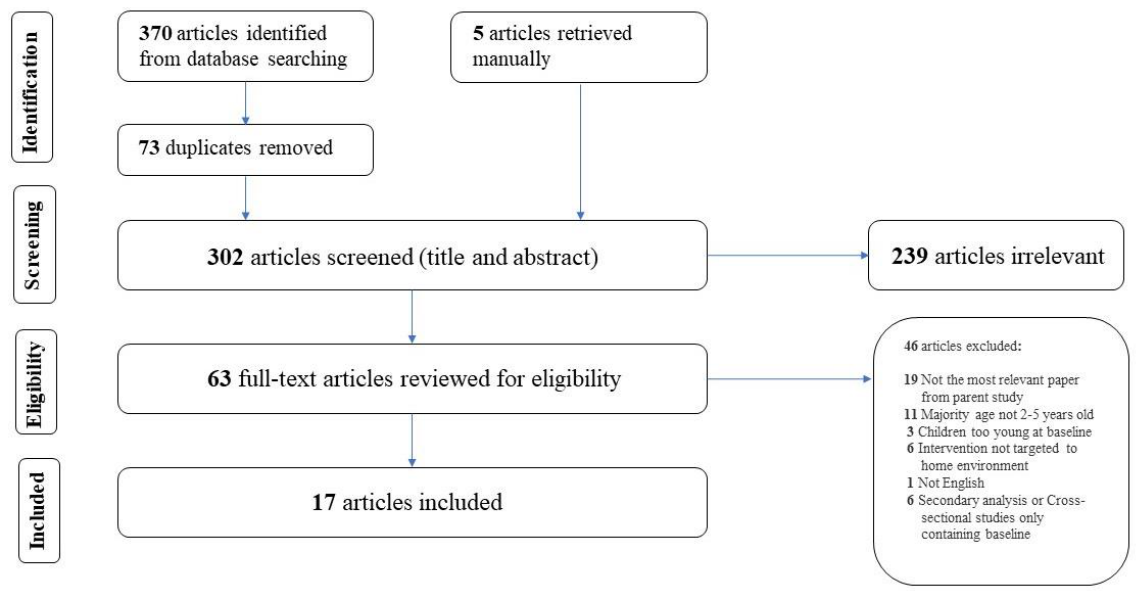
Figure 1. PRISMA flow chart [29] detailing identification, screening, and inclusion of articles.